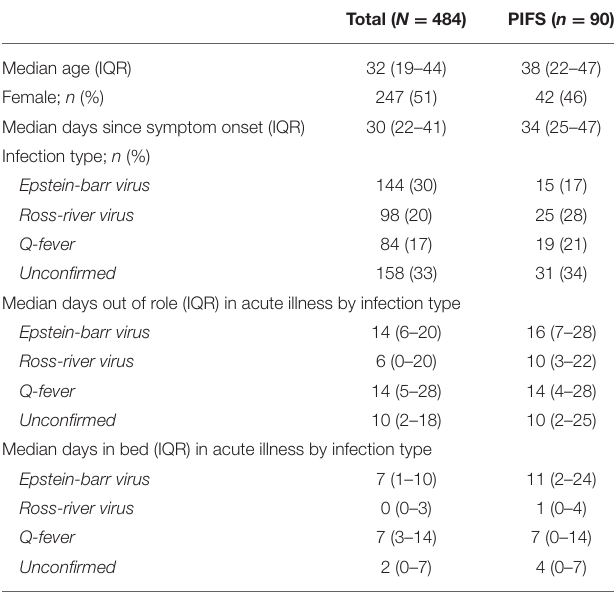
TABLE 1 | Demographics of the DIOS cohort ( n = 484) and PIFS sub-group ( n =